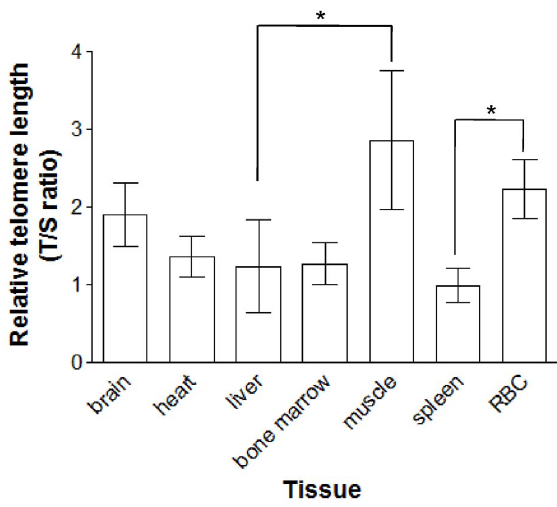
Figure 1. Mean relative telomere lengths ( ± SE) in the different somatic tissues (brain, heart, liver, bone marrow, muscle, spleen, RBC), tissues presenting significantly different telo- mere lengths are marked with an